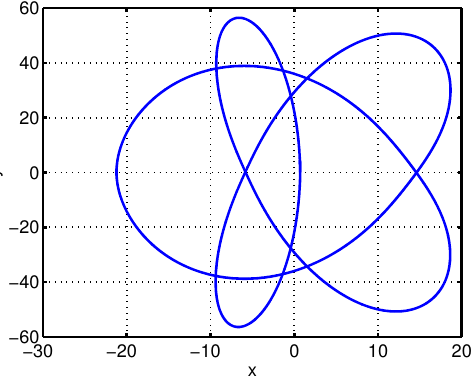
Fig. 4 Periodic orbit located at x = 0 . 7124, T = 173 for C = 1 . 1, and µ = 0 .